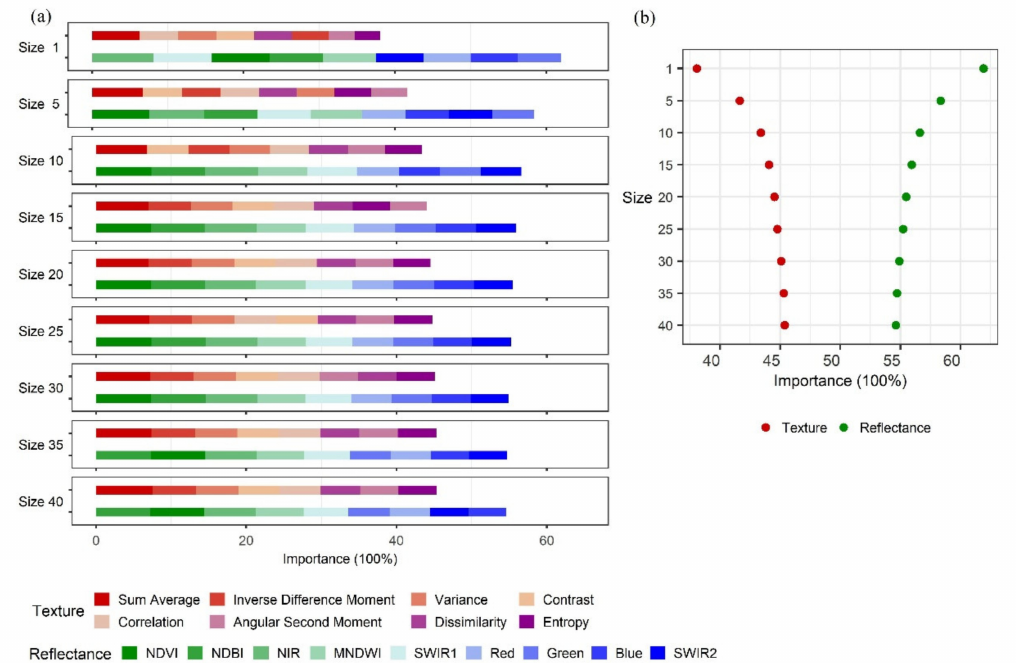
Figure 4. Variable importance in the Random Forest model to identify PV power plant trained with spectral variables and texture variables in different neighborhood sizes, ( a ) importance for each variable, ( b ) sum importance of variables from texture and